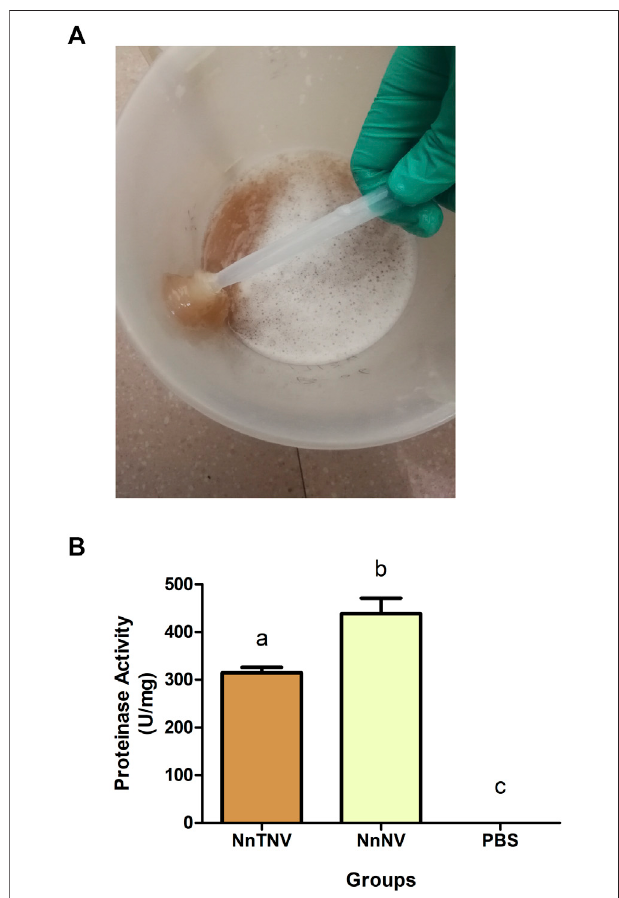
FIGURE 1 | Venomous sample preparation and proteinase activity assay. (A) Fresh Nemopilema nomurai tentacle tissues mixed with 50% (v/v) fi ltered natural seawater and completely autolyzed in 3 – 5 days. Supernatant was used in further experiments. (B) Proteinase activity of venomous samples. NnTNV: Nemopilema nomurai tentacle autolysis; NnNV: Nemopilema nomurai nematocyst venom. Both venomous samples showed signi fi cant proteinase activity, p < 0.05. NnNV was 438.6 U/mg. NnTNV was 314.4